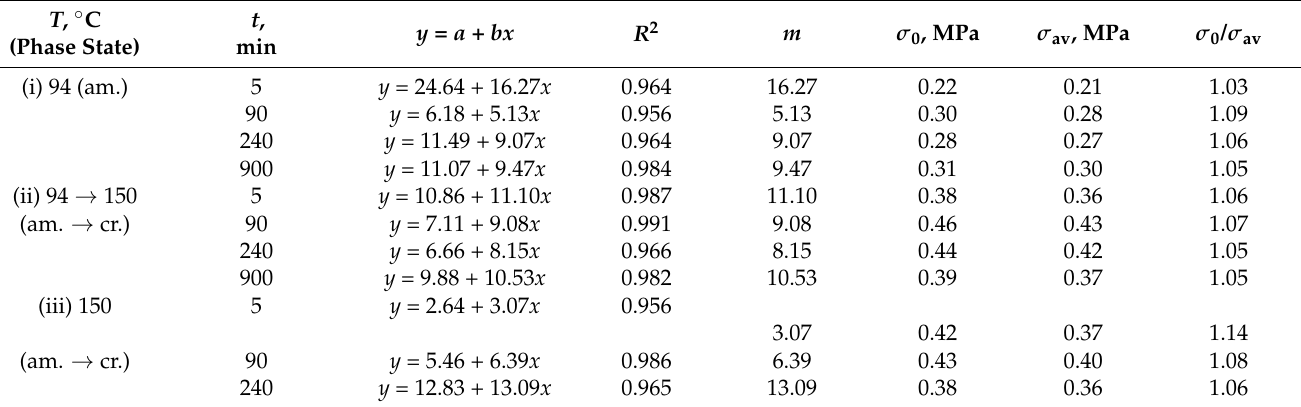
Table 1. Results of the Weibull’s analysis of the lap shear adhesion strength distribution for amPET– amPET interfaces self-healed (i) at T = 94 ◦ C for various intervals of healing time, (ii) at T = 94 ◦ C for various intervals of healing time followed by an additional self-healing step at T = 150 ◦ C for 5 min, and (iii) at T = 150 ◦ C for various t